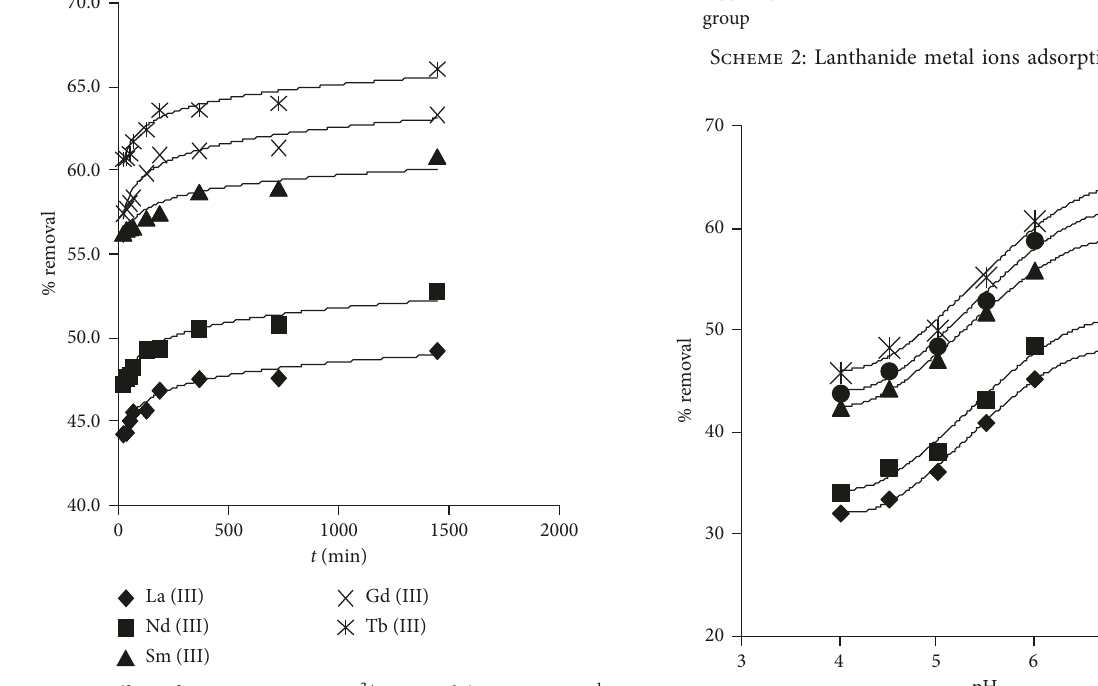
Figure 1: Effect of contact time on Ln 3+ removal ( C T 0.10g, and V 25 ° C, W (cid:31) (cid:31)